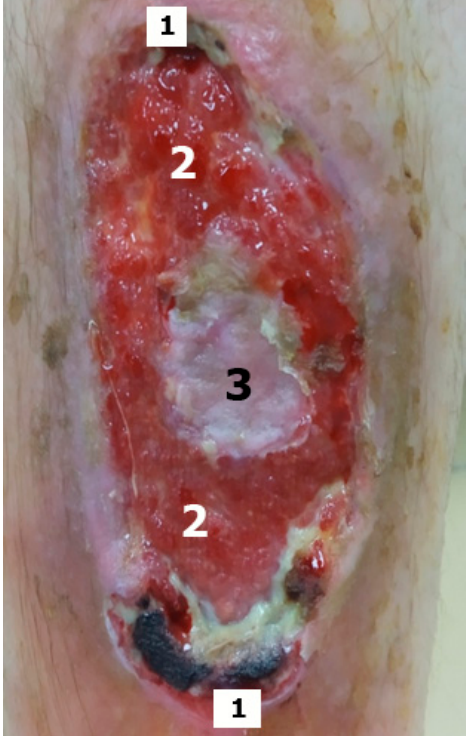
Figure 1. Diabetic foot ulcer and biomaterial sampling sites for histological examination. (1—the edges of the wound defect, 2—the walls of the defect, 3—the bottom of the wound defect). An image of DFS shows that when tissue is taken for histological examination only, for example, from one lower edge, then necrosis and fibrin (inflammation) will be visualized in the morphological material, and proliferative-regenerative processes will be visualized in the opposite sections. The photo also clearly shows the process of epithelialization in the centre of the wound.